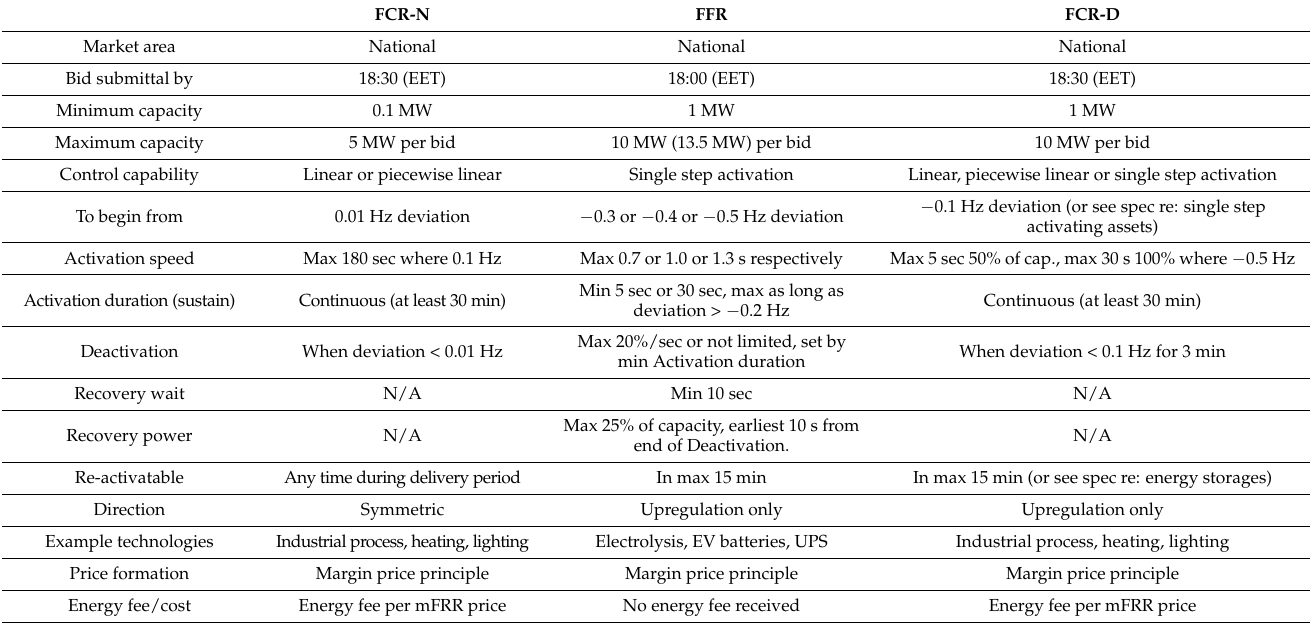
Table 1. Main features of the Nordic primary frequency reserve markets